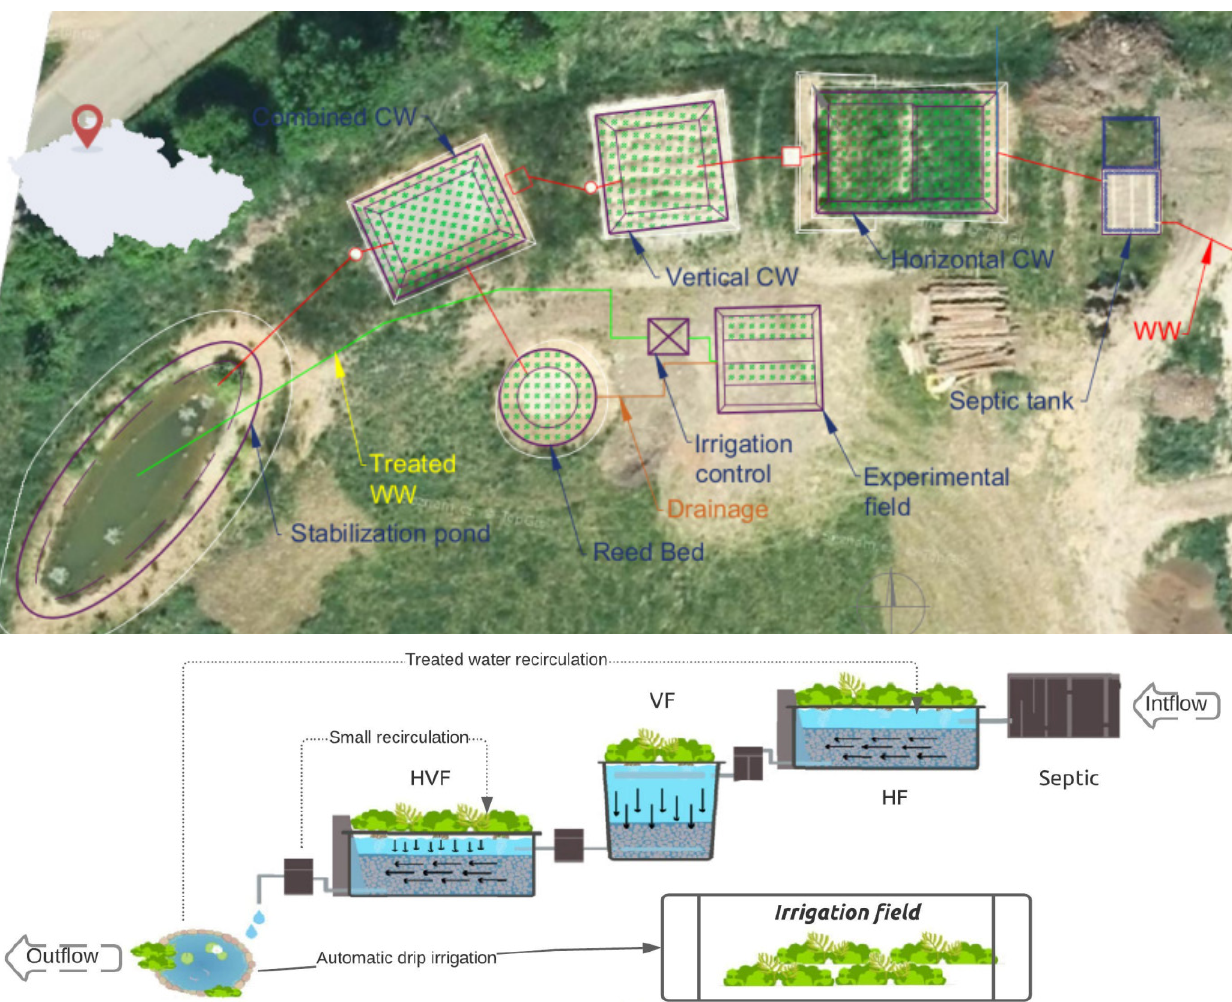
Figure 1. Map and layout of the hybrid system and the experimental irrigation field. WW = wastewater, CW = Constructed Wetland, HF = horizontal filter, VF = vertical filter, HVF = combined filter.